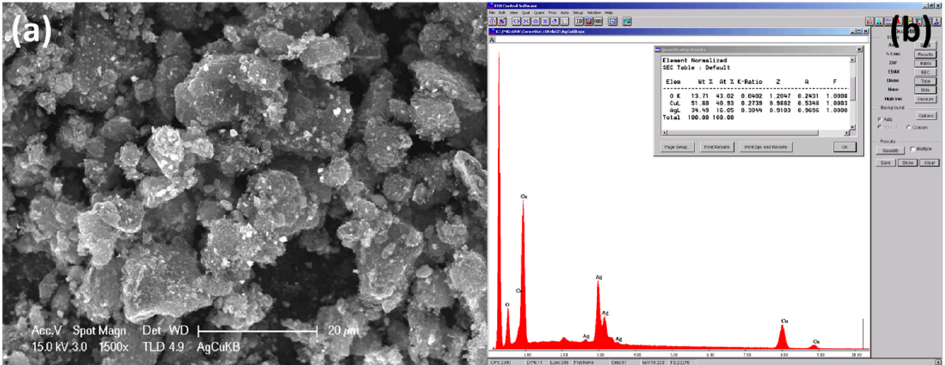
Figure 2. TEM images of the CuO/KB catalyst at three different magnifications. ( a ) 200nm; ( b ) 50 nm; ( c ) 5 nm.